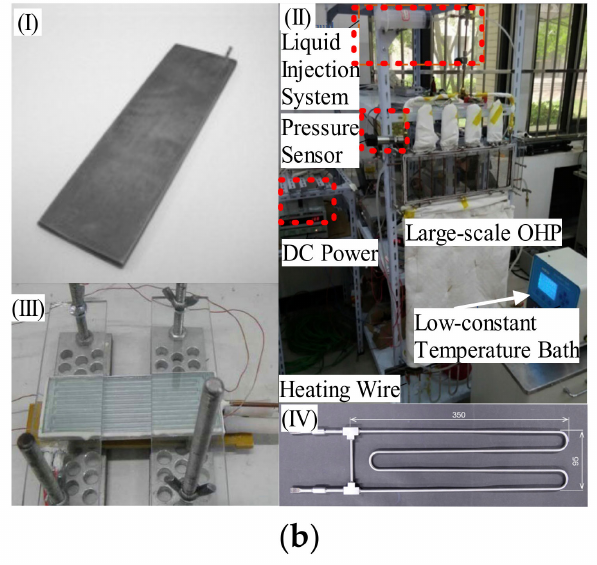
Figure 2. Two-dimensional and three-dimensional OHP devices. ( a ) An 18-channel 3D-OHP experi- mental device; ( b ) 2D OHP unit. (I) Thompson et al., (2011), [47]. (II) Zhao et al., (2017), [54]. (III) Lin et al., (2011), [55]. (IV) Tokuda et al., (2022),